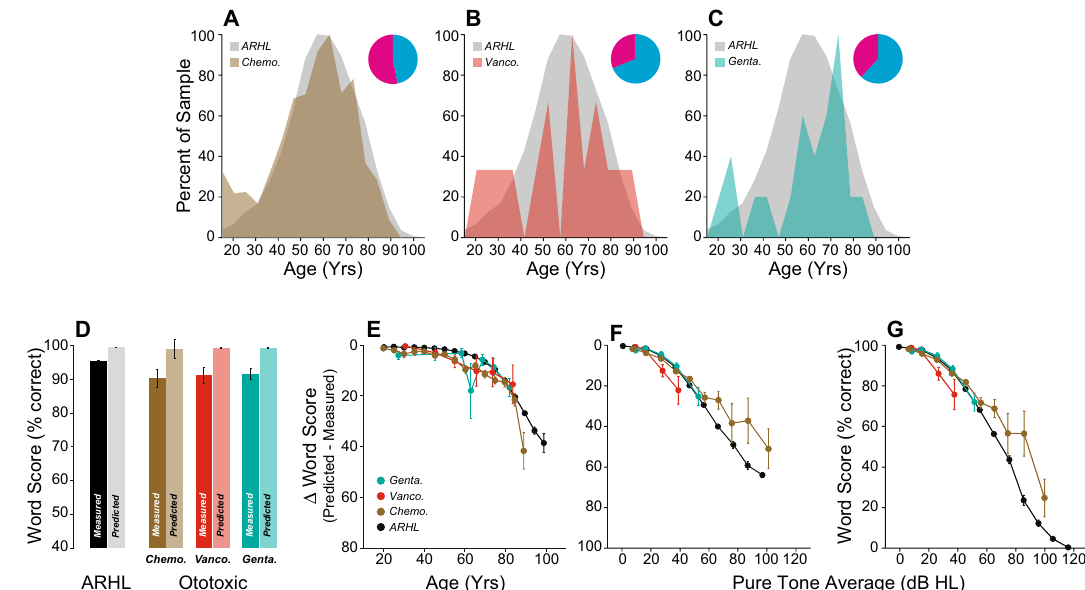
Figure 12. Intelligibility deficits in patients with exposure to ototoxic drugs. ( A – C ) Age distribution of patients with exposure to chemotherapeutics (Chemo., A ), Vancomycin (Vanco., B ) or I.V. Gentamicin (Genta., C ). Pie charts indicate the proportion of male (cyan) vs. female (magenta) for each group. ( D ) Comparison of mean WRS as measured in patients exposed to ototoxic drugs or predicted by the speech intelligibility curve. Scores were compared with patients presenting ARHL. ( E – G ) Speech Intelligibility deficits as a function of age ( E ) or pure-tone average ( F , G ). Legend in ( E ) applies to ( F , G